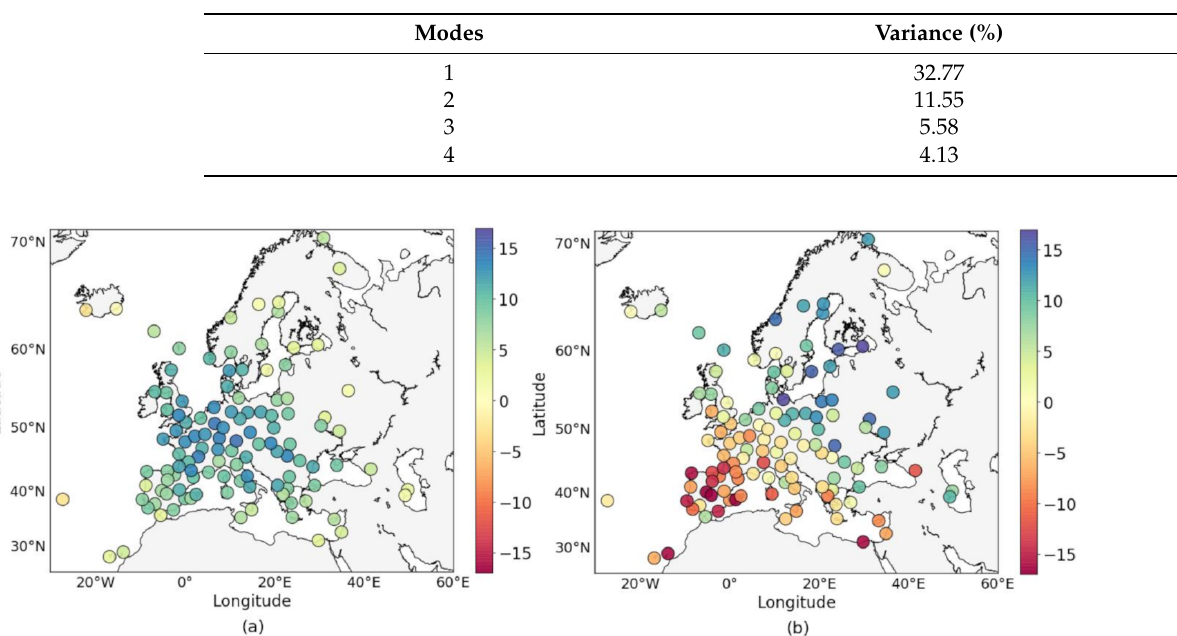
Figure 2. First ( a ) and second ( b ) spatial pattern of the weekly GPS Up coordinate residuals.